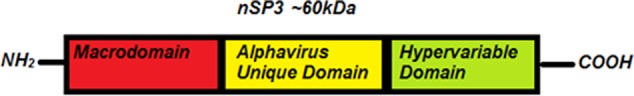
Schematic diagram of nsP3. The nsP3 protein consists of three regions: macrodomain, alphavirus unique domain, and hypervariable domain. The macrodomain is highly conserved among all alphaviruses and contains the ADP-ribose-binding site. The alphavirus unique domain contains many serine and threonine residues and is the location of the zinc-binding site. The hypervariable domain comprises the final third of the protein at the C-terminal, containing many sites for phosphorylation. This region varies greatly among the alphaviruses in both length and sequence.